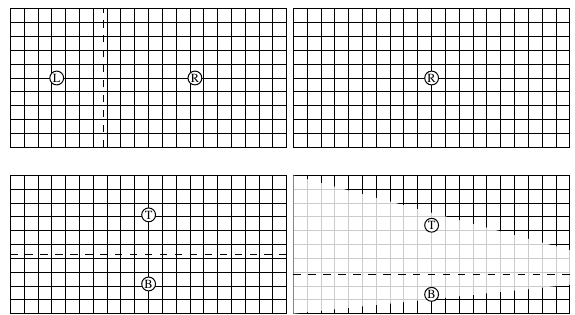
(a) Original images with a pole inside (left) and outside (right) the image domain. Up to 4 resampling grids are used to perform the piecewise-projective radial image resampling : T op, B ottom, L eft and R ight.